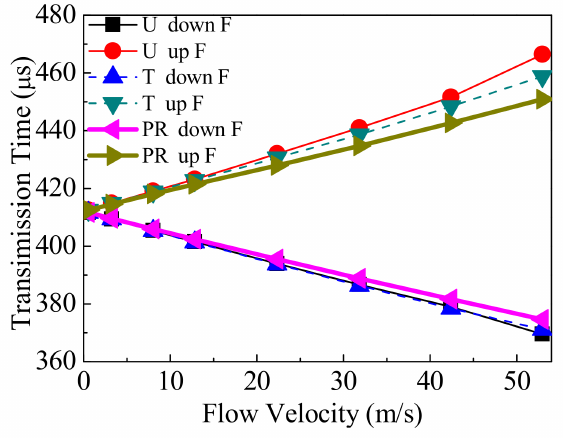
Figure 17. Transit time in different flow